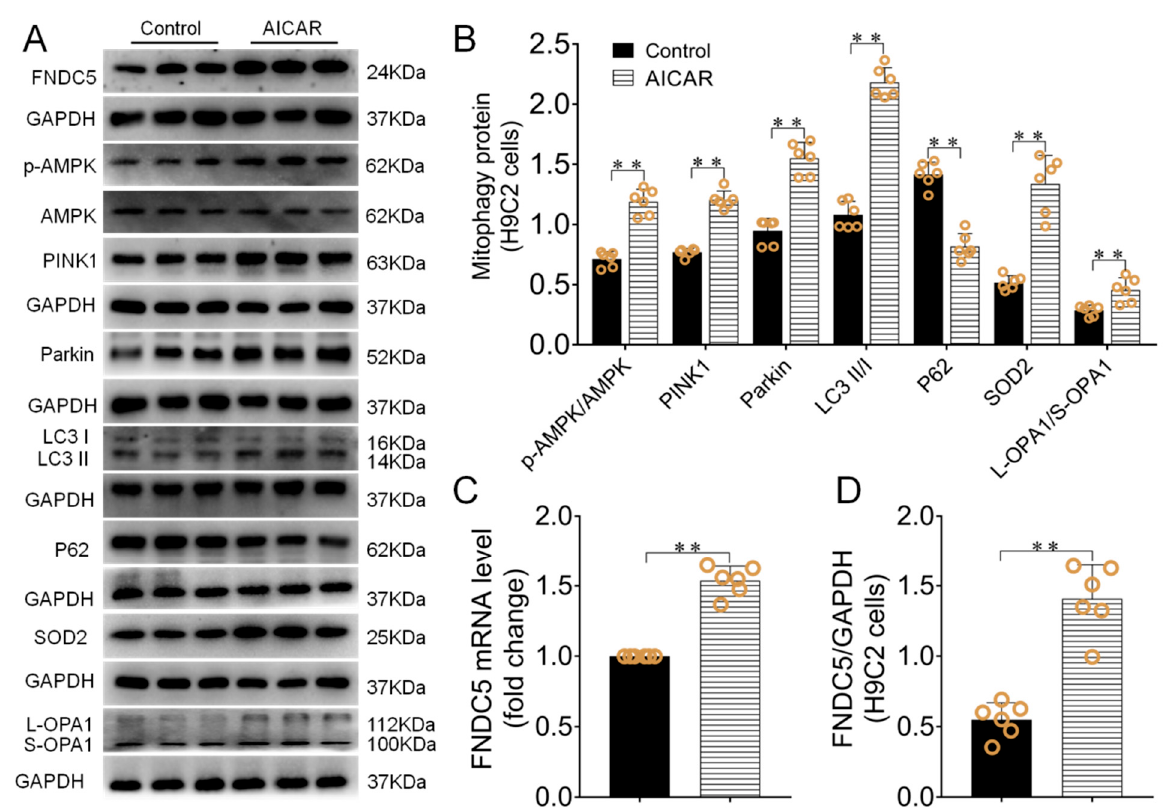
Figure 6. AICAR intervention enhanced irisin/FNDC5 expression, increased mitophagy and antioxidant function in H9C2 cells. ( A , B ) The effect of AICAR intervention on PINK1, Parkin, P62, SOD2 protein expressions and p-AMPK/AMPK, L-OPA1/S-OPA1 and LC3II/I ratio of H9C2 cells. ( C ) H9C2 cells Irisin/FNDC5 mRNA expression after AICAR intervention. ( D ) The effect of AICAR intervention on irisin/FNDC5 protein expressions. Data are expressed as mean ± SEM. ** p < 0.01. Abbreviations: FNDC5: transmembrane protein fibronectin type III domain protein 5; AMPK: adenosine monophosphate (AMP)-activated protein kinase; PINK1: PTEN-induced kinase 1; Parkin: E3 ubiquitin ligase parkin; LC3II/I: microtubule- associated protein light chain 3; P62: SQSTM1/p62, SOD2: superoxide dismutase 2; OPA1: optic atrophy protein-1.